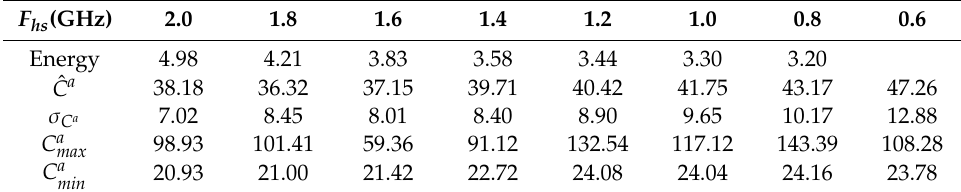
Table 10. Interactive governor with conf1 and di ff erent F hs values. Vid1.